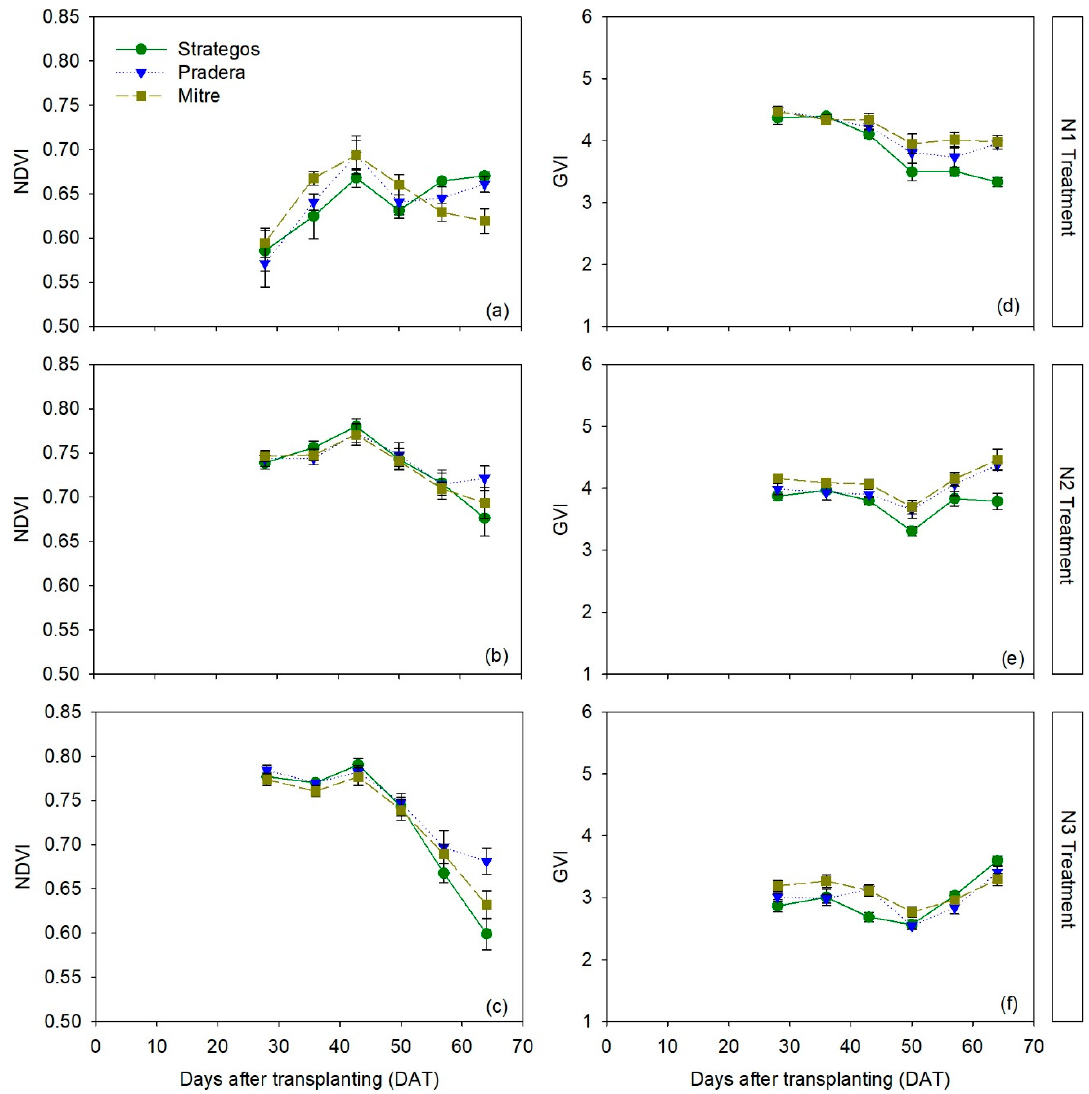
Figure 4. Temporal dynamics of normalized difference vegetation index (NDVI) (panels a – c ) and green ratio vegetation index (GVI) (panels d – f ) measurements of three cultivars of cucumber ( Cucumis sativus L. ‘Strategos’, ‘Pradera’ and ‘Mitre’) under three N treatments (N1, N2 and N3). Values are means ± SE.